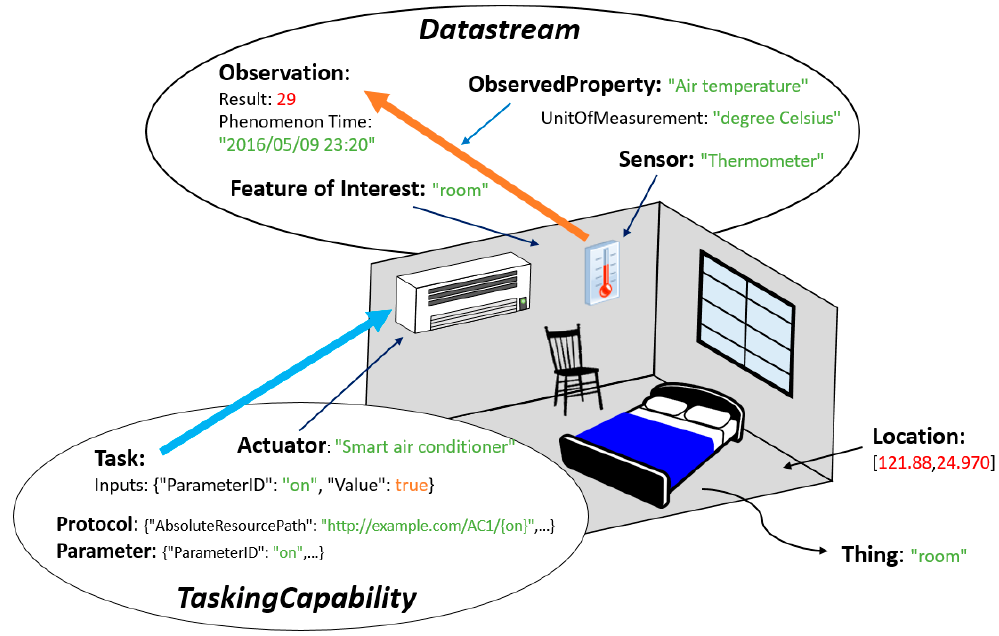
Figure 4. An example of the Extended SensorThings API.